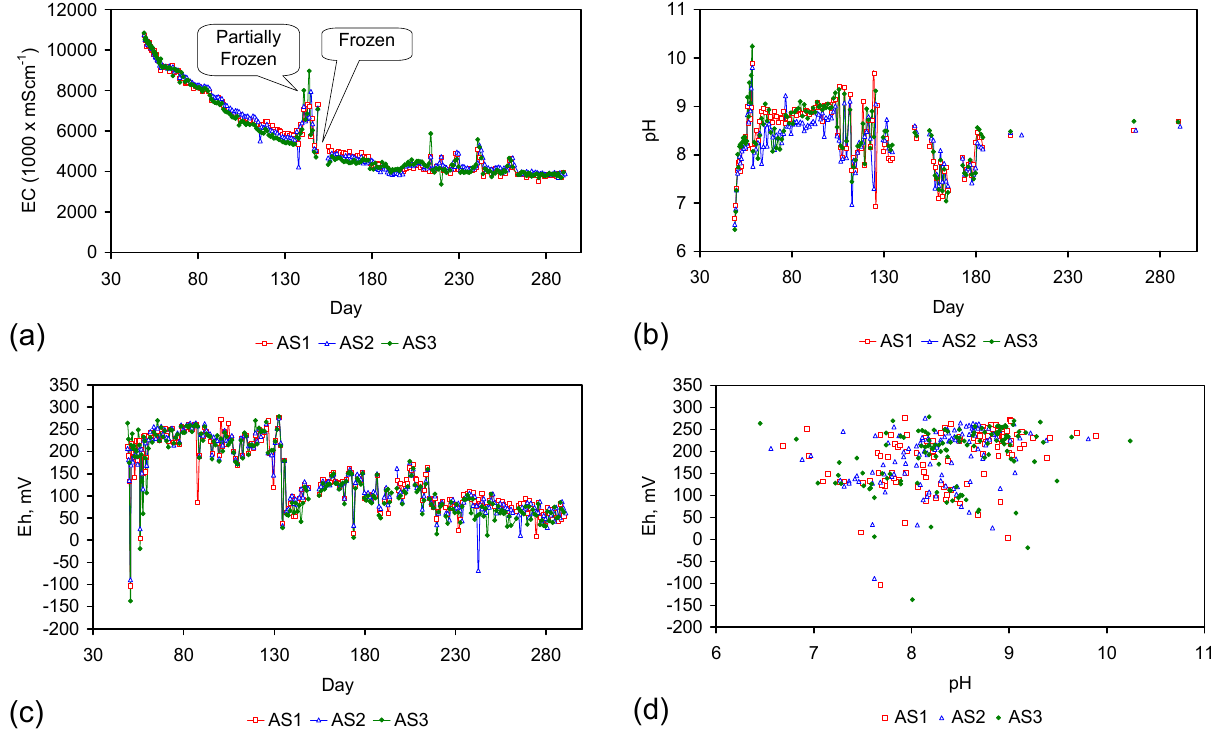
Figure C11. ( a ) EC vs. day; ( b ) Eh vs. day; ( c ) pH vs. day; ( d ) pH vs. Eh. AS1 = 44 g·L − 1 ; AS2 = 55 g·L − 1 ; AS3 = 49 g·L − 1 . Reactor Size: 0.3 L; Feed Water volume: 0.2